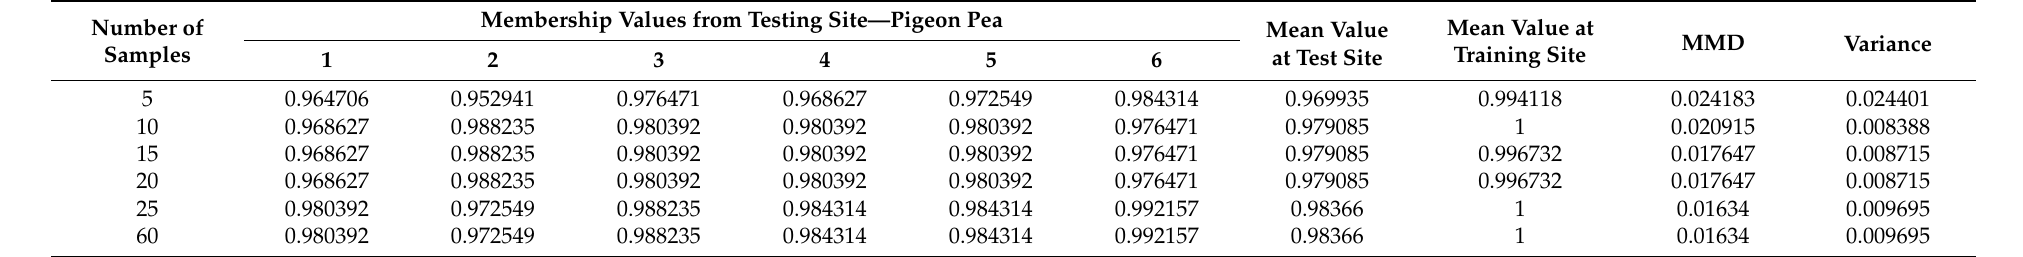
Table 11. Effect of increase in sample size by comparing membership values between Pigeon Pea Training fields and Pigeon Pea Test fields for proximity—ISM training parameter based PCM